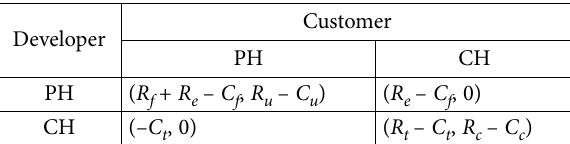
Table 1. Payment matrix between developers and customers without subsidies